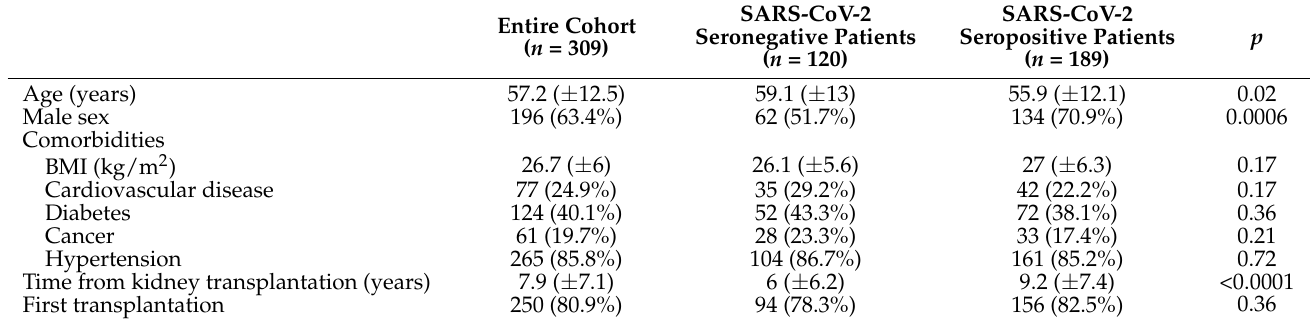
Table 4. Patient characteristics according to the absence or presence of seroconversion after three vaccine